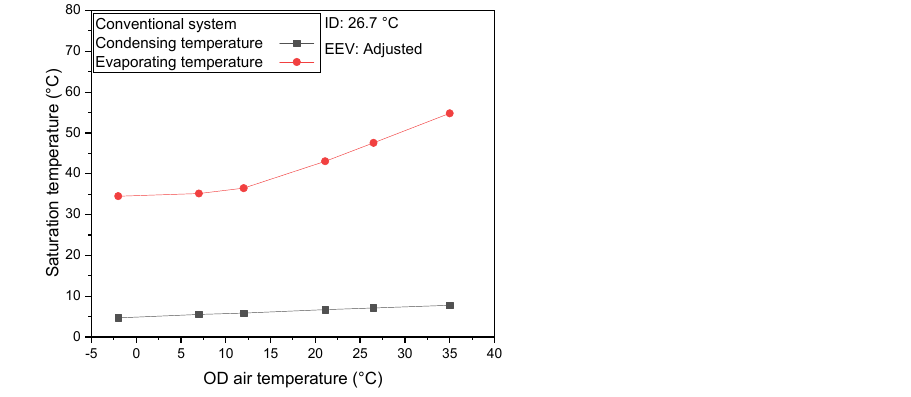
Figure 6. Saturation temperatures of conventional system according to OD air temperature.